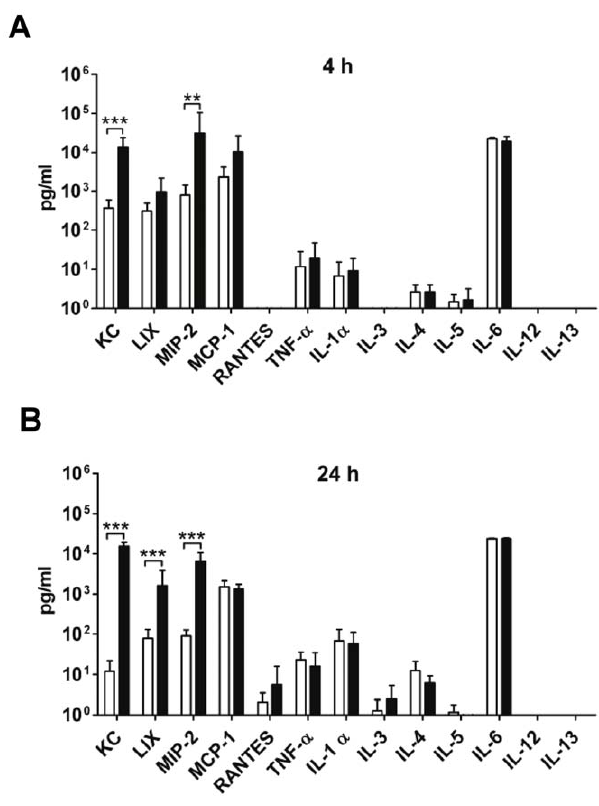
Figure 4. Increased levels of KC, LIX and MIP-2 during infection with 3348 D spyCEP . Thirteen different chemokines were measured in the individual mouse air pouch lavages collected at 4 h ( A ) and 24 h ( B ) post-infection with 3348 (white bars) and 3348 D spyCEP (black bars). Results are shown as means and SEM of one representative experiment using 8 mice per group. Statistical significance was tested by Mann- Whitney U: P , 0.01 (**), P , 0.001 (***).